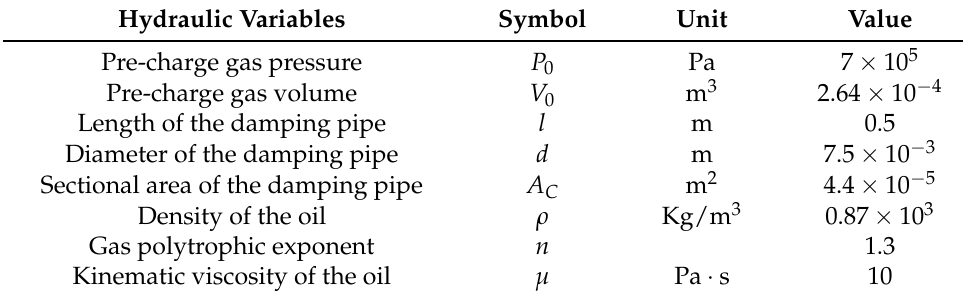
Table 1. Initial value of hydropneumatic variables.